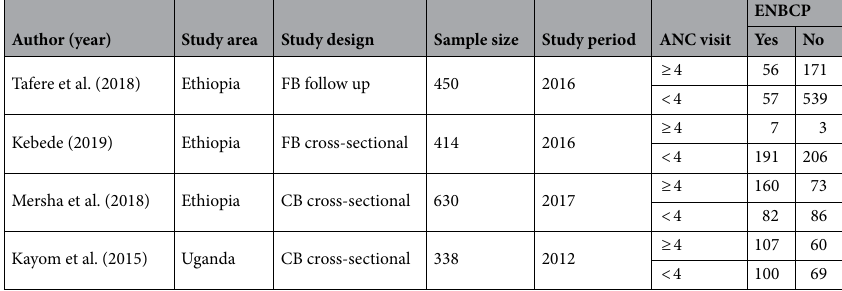
Table 3. Characteristics of studies included to identify the effect of number of ANC visits on essential newborn care practice in East Africa.